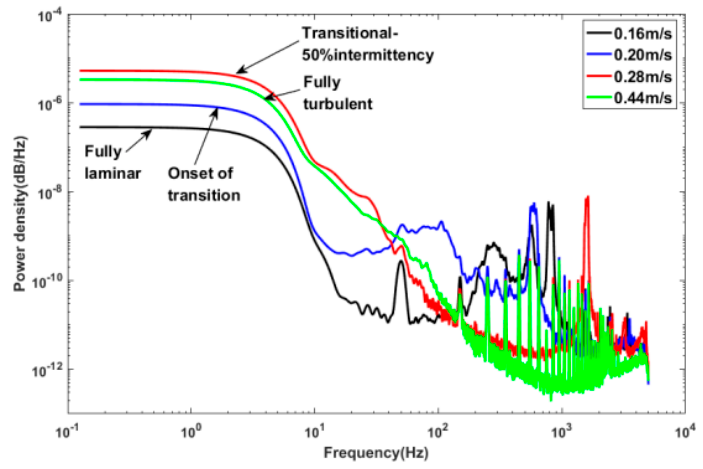
Figure 15. A waterfall plot of the spectra from the voltage-time traces of sensor 2 at different velocities.